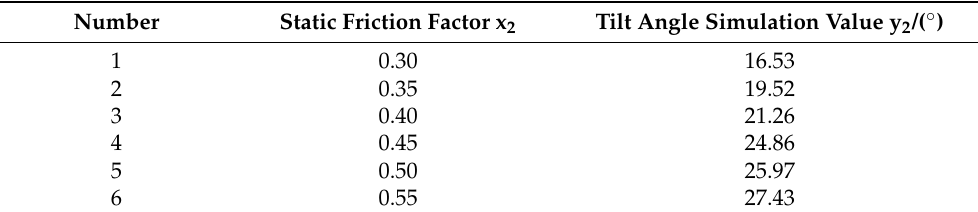
Table 4. Experimental scheme and results of static friction coefficient simulation experiment.